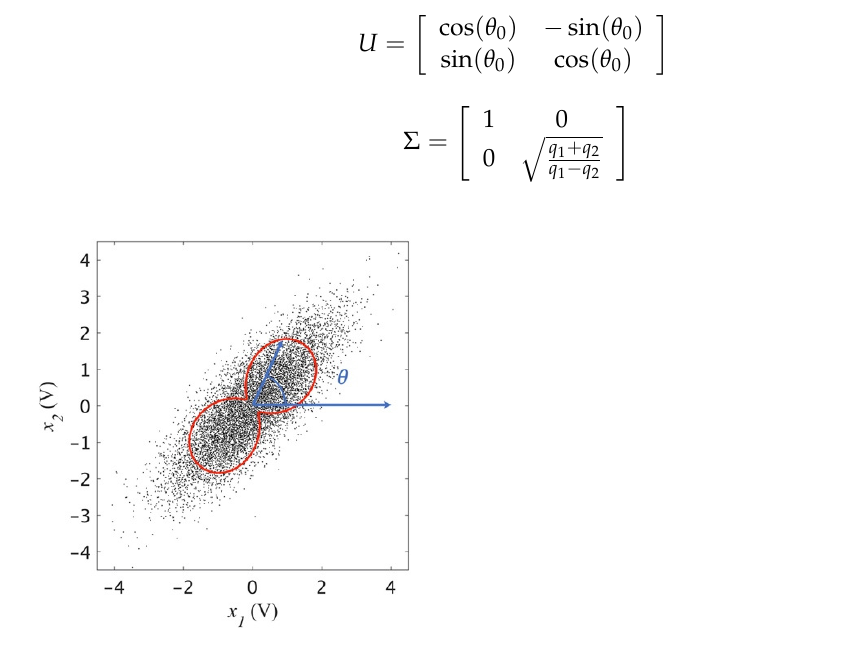
Figure 3. Mixed signal and second order moment.